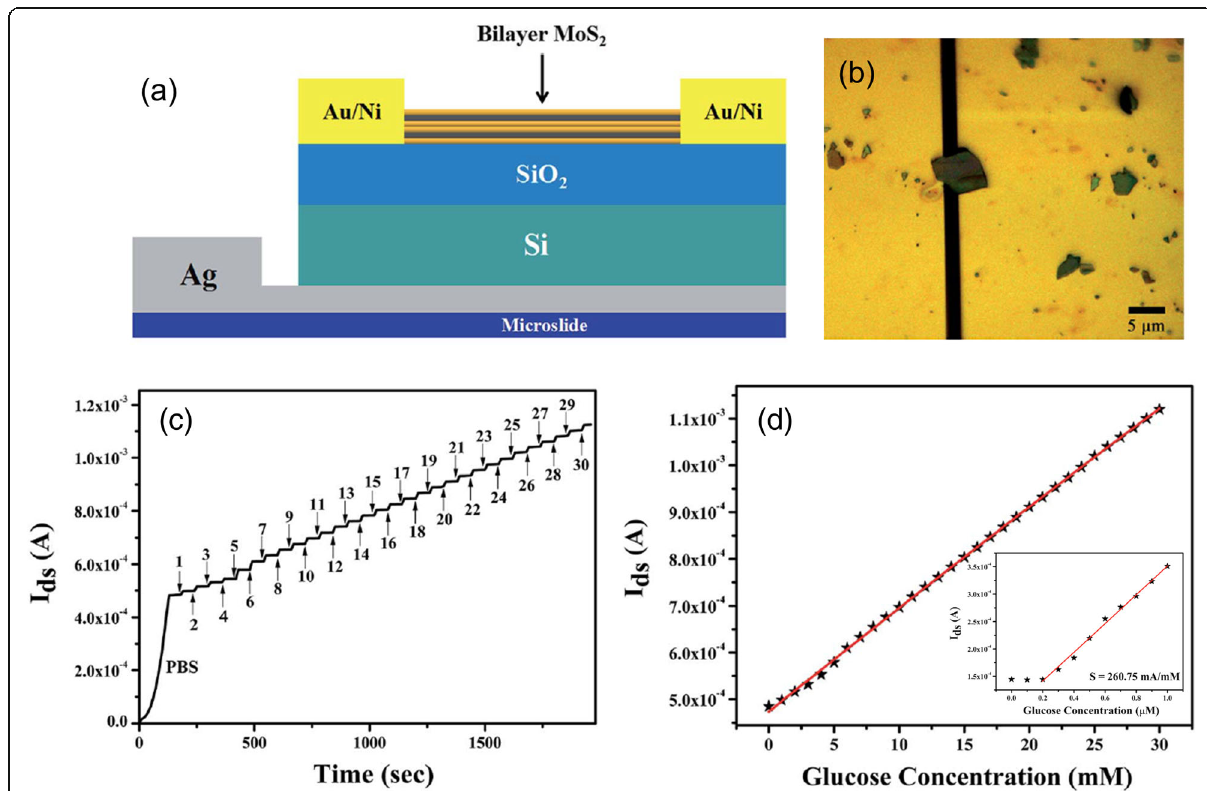
Fig. 4 a Schematic of the back-gated MoS 2 transistor. b Optical microscopy image of the MoS 2 channel material between the source and drain electrodes. c The real-time current responses to different glucose concentrations. d The response current I ds of the MoS 2 FET as a function of glucose concentrations, from 0 to 30 mM. The inset shows the response current extracted for lower glucose concentrations, from 0 to 1.0 μ M. Reprinted under CC BY-NC 3.0 from